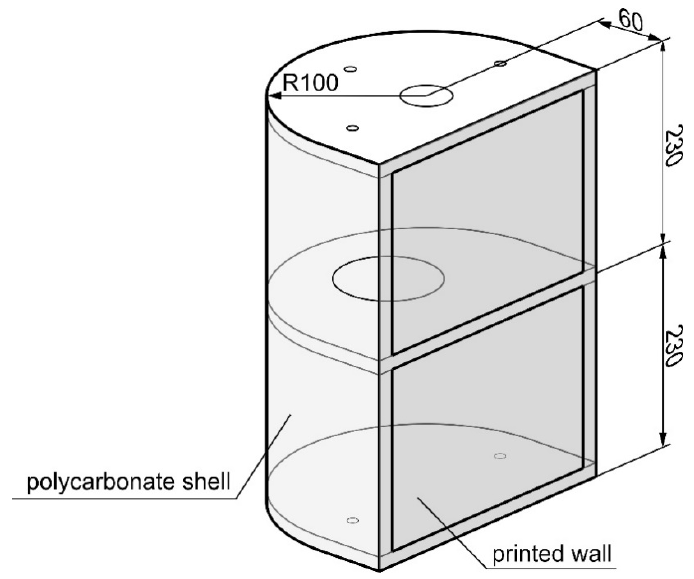
Figure 10. Schematic diagram of the torsion box model.